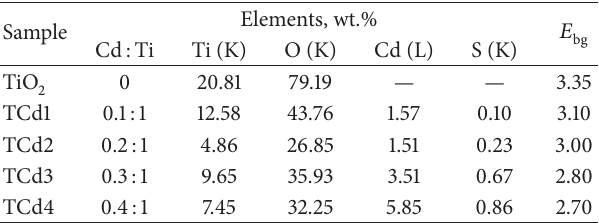
Table 2: Elemental compositions and band gaps of the as-synthe- sized CdS/TiO 2